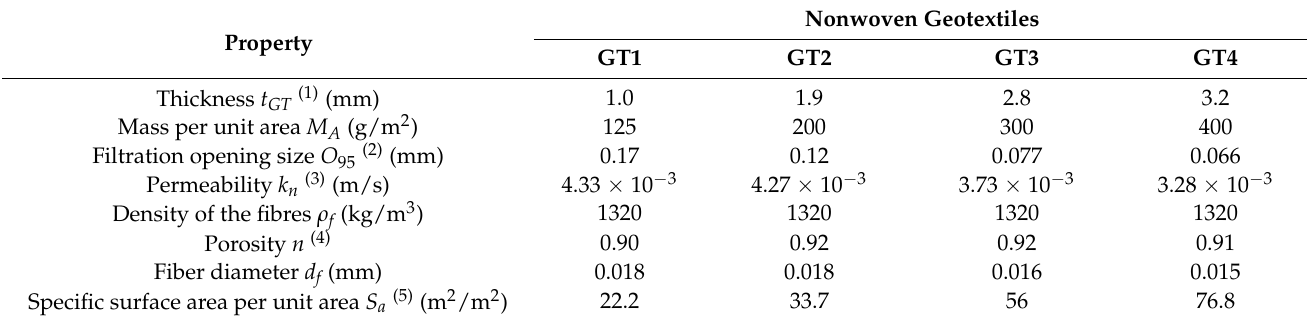
Table 1. Properties of selected nonwoven geotextiles.